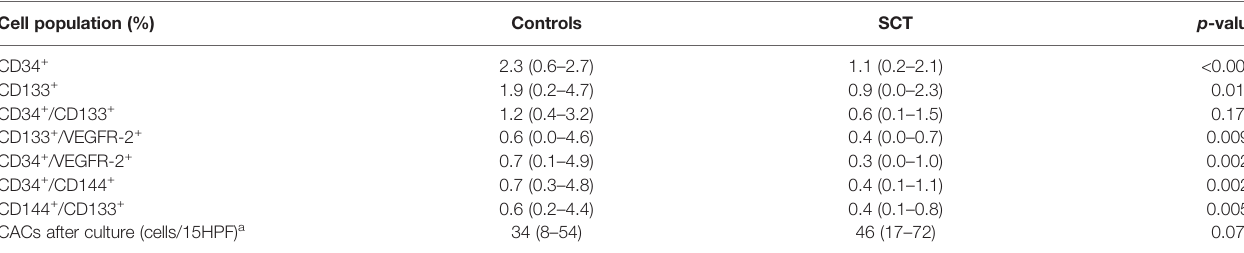
TABLE 4 | cEPCs at the lymphocyte gate and CAC cell numbers after culture in SCT and controls. Cell population